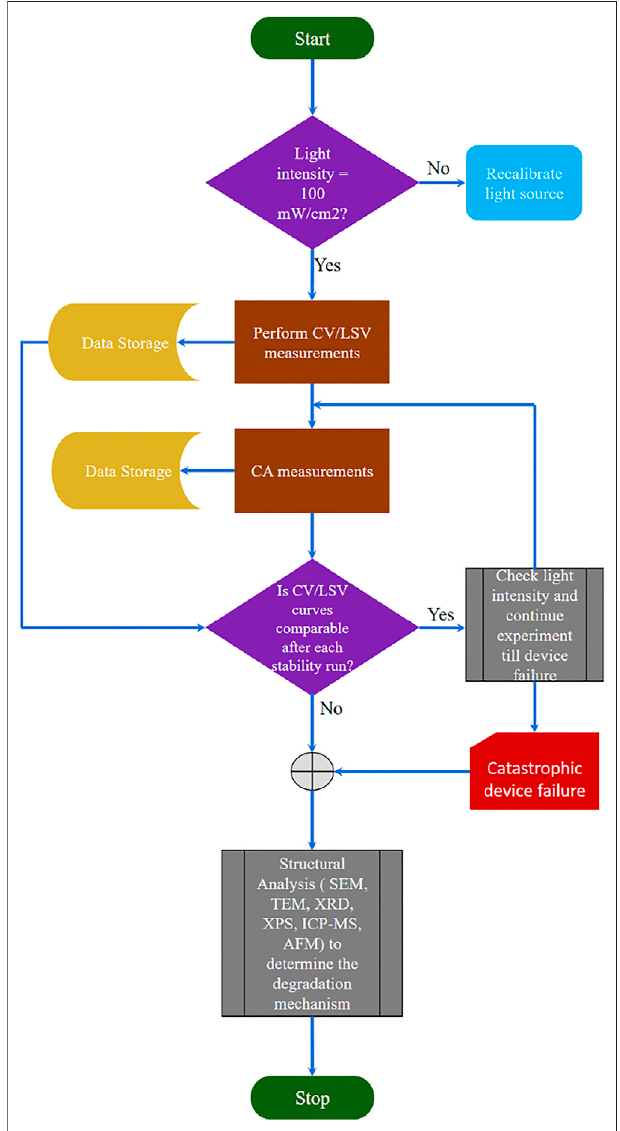
FIGURE 4 | Flowchart illustrating the steps for performing long-term stability